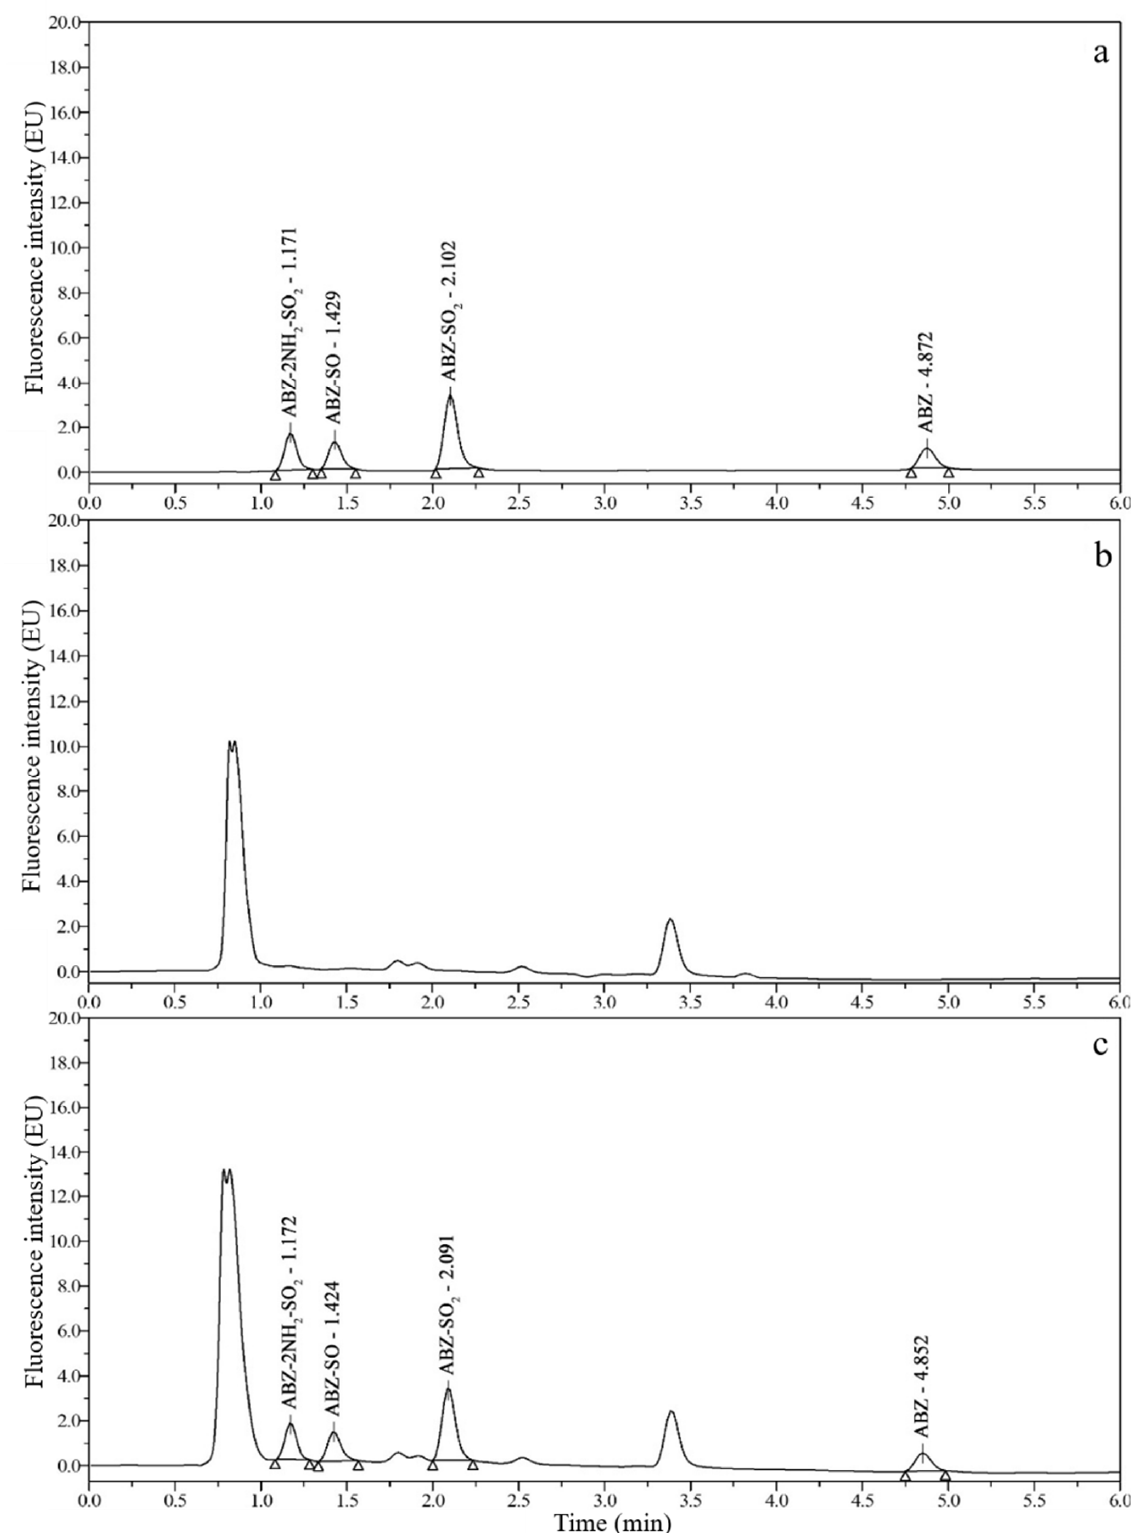
Figure 3. Chromatograms of 10 µ g/kg ABZ-2NH 2 -SO 2 , 50 µ g/kg ABZ-SO, 10 µ g/kg ABZ-SO 2 and 50 µ g/kg ABZ standards ( a ); blank chicken muscle ( b ); and blank chicken muscle spiked with 10 µ g/kg ABZ-2NH 2 -SO 2 , 50 µ g/kg ABZ-SO, 10 µ g/kg ABZ-SO 2 and 50 µ g/kg ABZ standards ( c